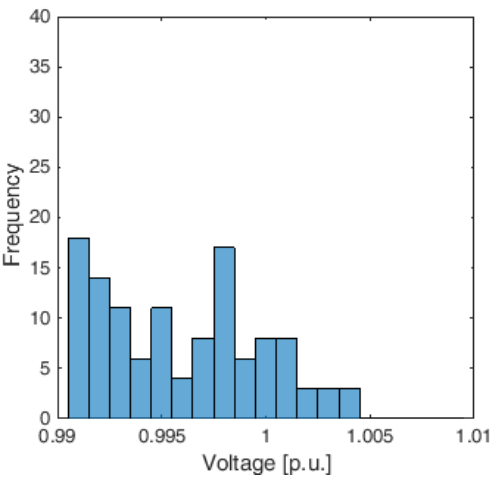
Figure 10. The histogram of the distribution of the nodal voltages for the Decentralized APP in Case 3 with the partitioning in seven VCZs